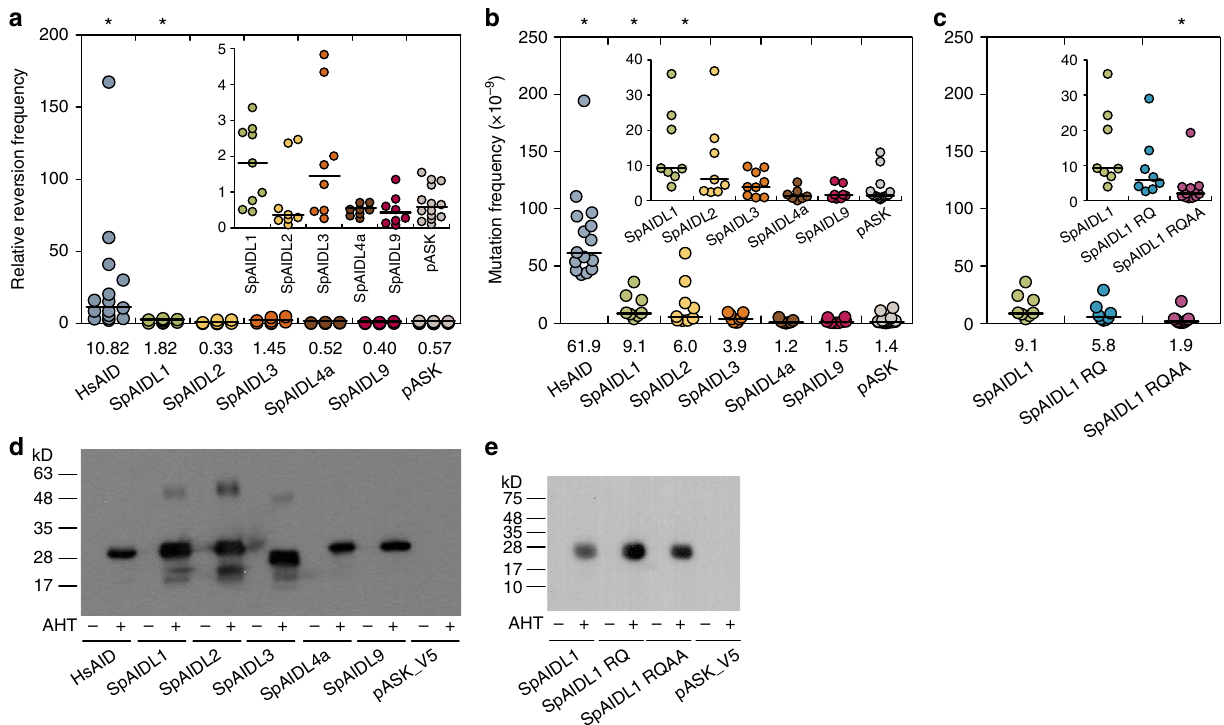
Fig. 3 Enzymatic activities of SpAIDLs. a – c Deaminase activities of each indicated protein were measured in bacterial reversion assays using either a Kanamycin resistance reporter plasmid ( a ) or the endogenous rpoB gene as the reporter ( b , c ). Note that the SpAIDL1 dataset from b is shown again in c for clarity. The horizontal bars represent the median (numerical value below each column), and p -values (for each deaminase compared to empty pASK for a , b , and compared to wildtype SpAIDL1 for c ) were calculated using a Willcoxon rank sum for unpaired data. Datasets with p < 0.05 are marked with an asterisk ( a : HsAID p = 0.000001 and SpAIDL1 p = 0.02087; b : HsAID p = 6.6 × 10 − 9 , SpAIDL1 p = 0.0005, and SpAIDL2 p = 0.0014; c : SpAIDL1 RQAA p = 0.00048). The inset represents a magni fi ed view omitting all data points of HsAID ( a , b ) and one datapoint of SPAIDL2 ( b ) for clarity. SpAIDL1 RQ and SpAIDL1 RQAA are mutants of SpAIDL1 in which either two (H86R and E88Q) or four (H86R, E88Q, C123A, and C126A) of the conserved active site residues were altered. d , e Western blot analysis of the expression of the indicated V5-tagged deaminases in bacteria induced with AHT for 3 h ( + ) or not ( − ). Note that the enzymatic activities were tested with untagged versions of the proteins. The empty pASK_V5 plasmids served as a control. The predicted sizes for V5-tagged HsAID, SpAIDL1 (and the mutants thereof), 2, 3, 4a, and 9 are 25.4, 24.0, 23.5, 22.3, 23.6, and 24.6 kD,